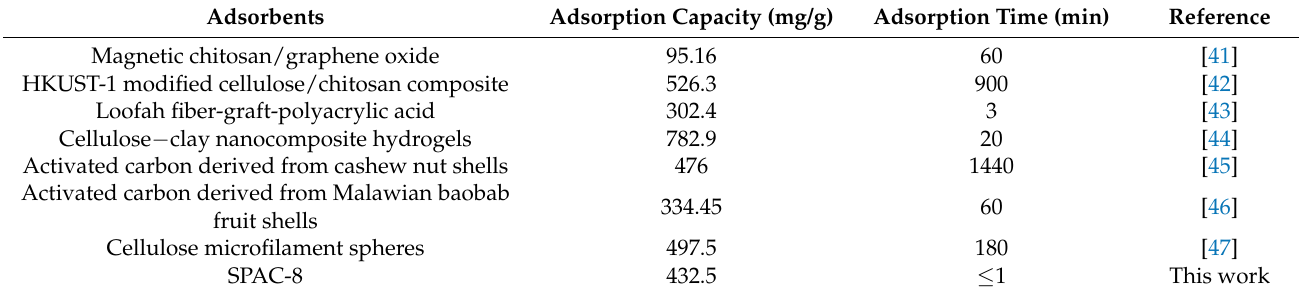
Table 3. Comparisons of adsorption capacities towards MB with other adsorbents.